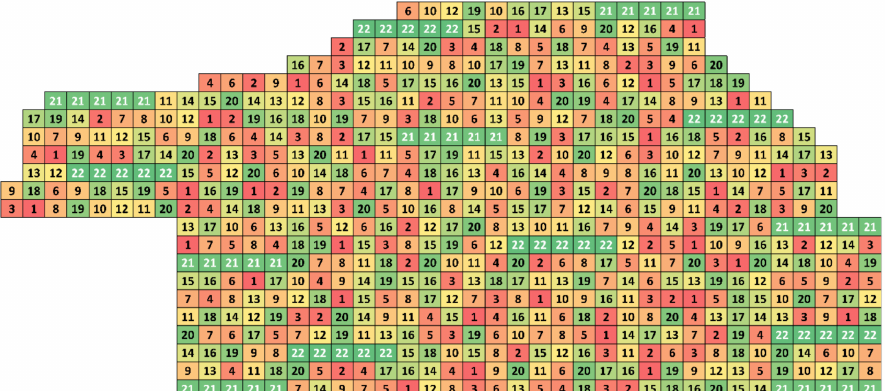
Figure 2. Design combining both Minimum Inbreeding and Optimum Neighborhood Algorithm designs. Numbers designate individual clones’ IDs. Numbers in white color represent clonal rows utilizing MI algorithm. Remaining entries where optimized by ONA